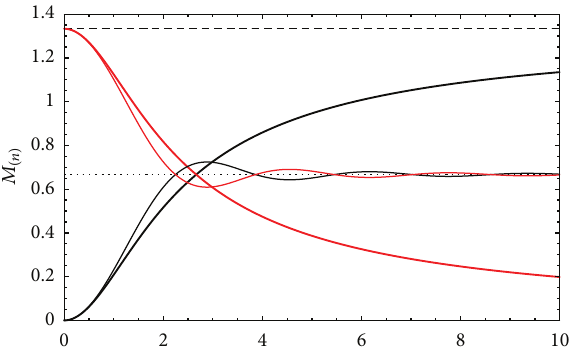
Figure 5: Total energy of localized solutions (topological masses, 𝑀 (𝑛) ) as function of the parameter 𝑛 for hyperbolic (thick lines) and trigonometric (thin lines) 3 -cyclic deformation chains. Results are for 𝑀